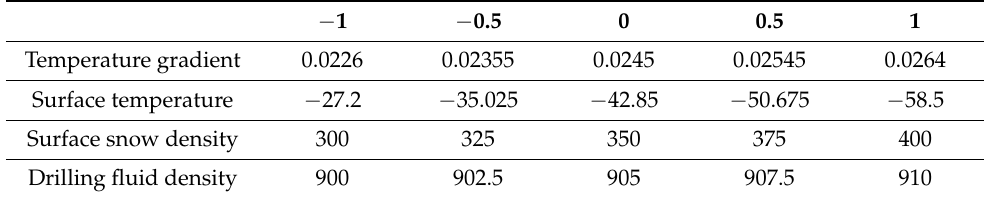
Table 4. Sensitivity analysis factor values.